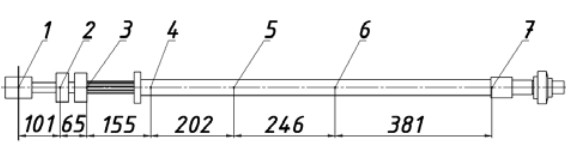
Fig. 1. Test bench.